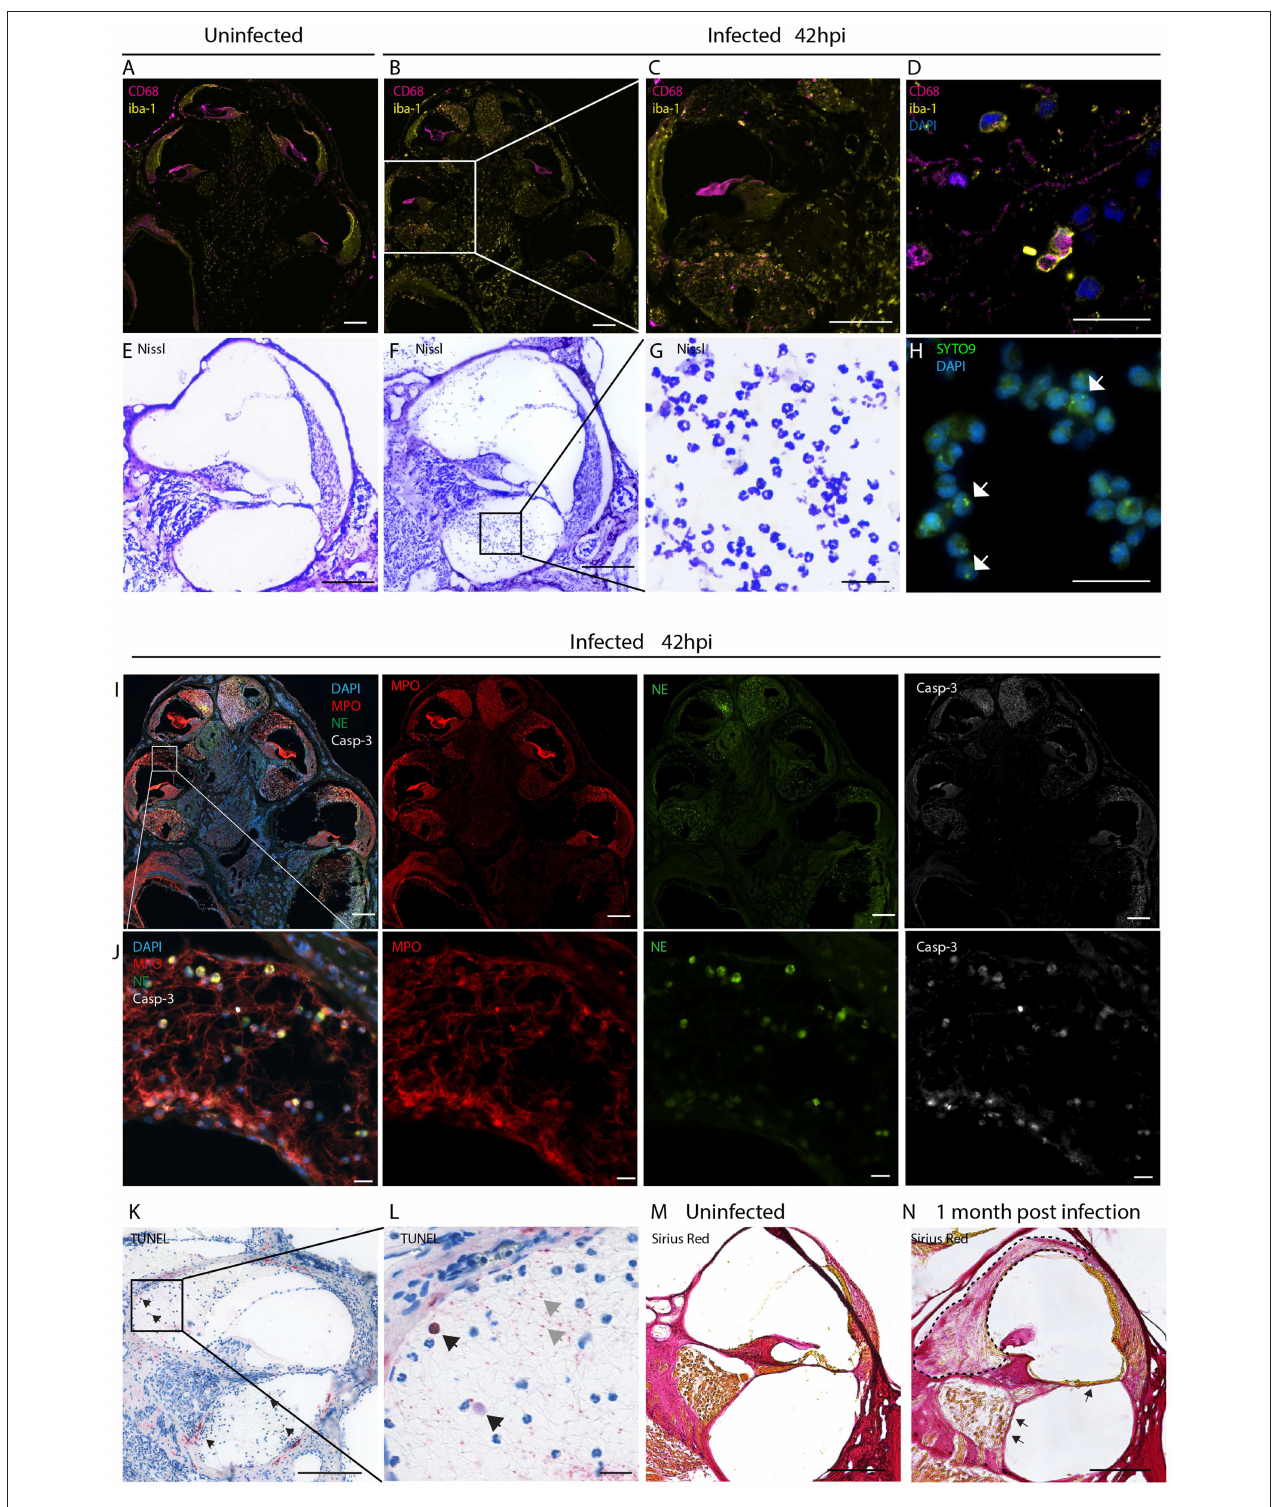
FIGURE 1 | Inflammatory infiltration of the perilymphatic spaces. Immunostainings for macrophages markers CD68 and iba1 on mid-modiolar sections of rat cochlea (A) uninfected and (B) 42h post infection with S. pneumonia. (C) Close up of a middle turn and (D) of the perilymphatic space. (E) Nissl staining of a cochlear middle turn of an (E) uninfected animal and (F) 42h post infection. (G) Higher magnification of cells infiltrating in the perilymphatic space showing the characteristic